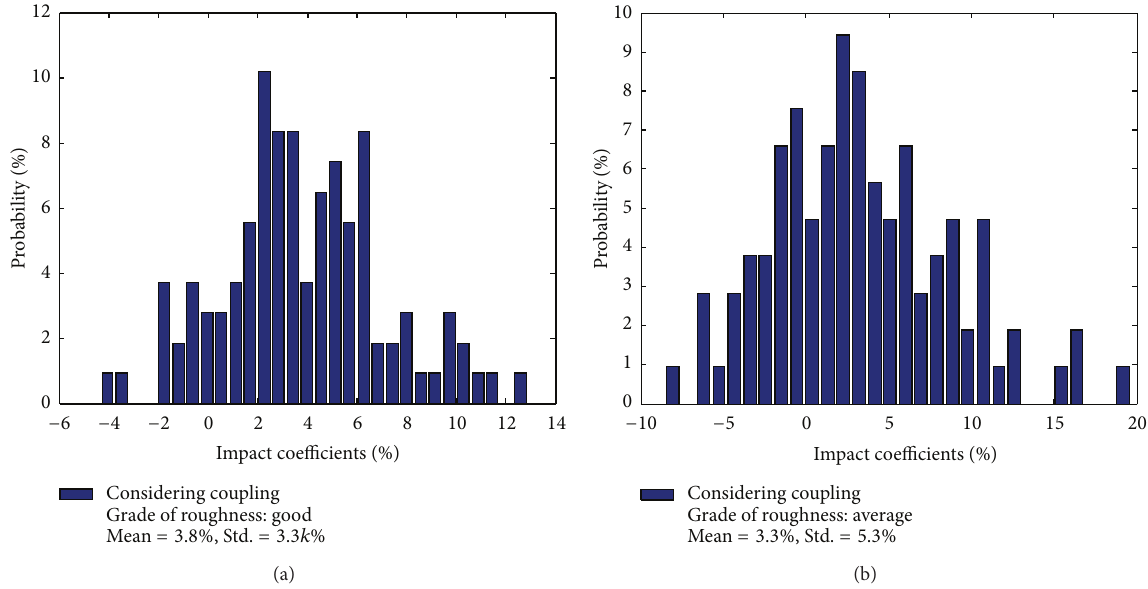
Figure 14: Probabilistic distribution of vertical moment impact coefficients at point A of the bridge under the conditions of different surface roughness: (a) good; (b)